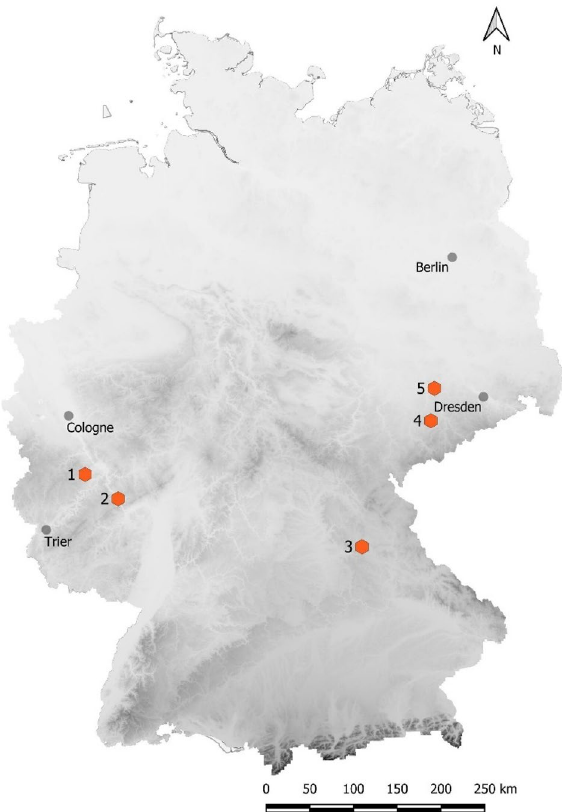
Figure 5. Location of the observed hibernacula in